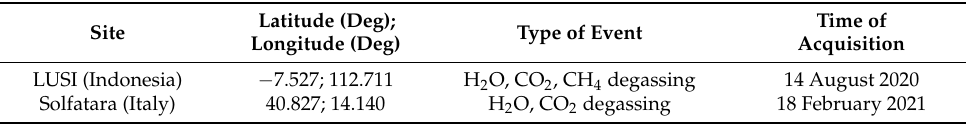
Table 2. Test sites and PRISMA